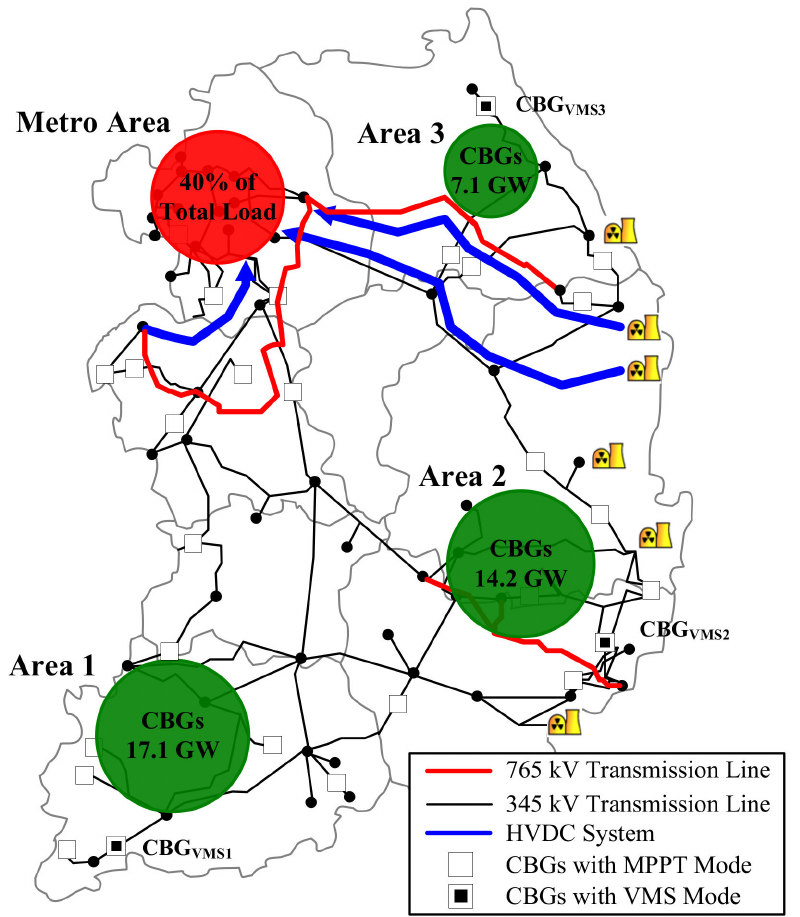
Figure 1. The Korean 2030 power system plan with high renewable penetration. CBGs, converter- based generators; MPPT, maximum power point tracking; VMS, virtual